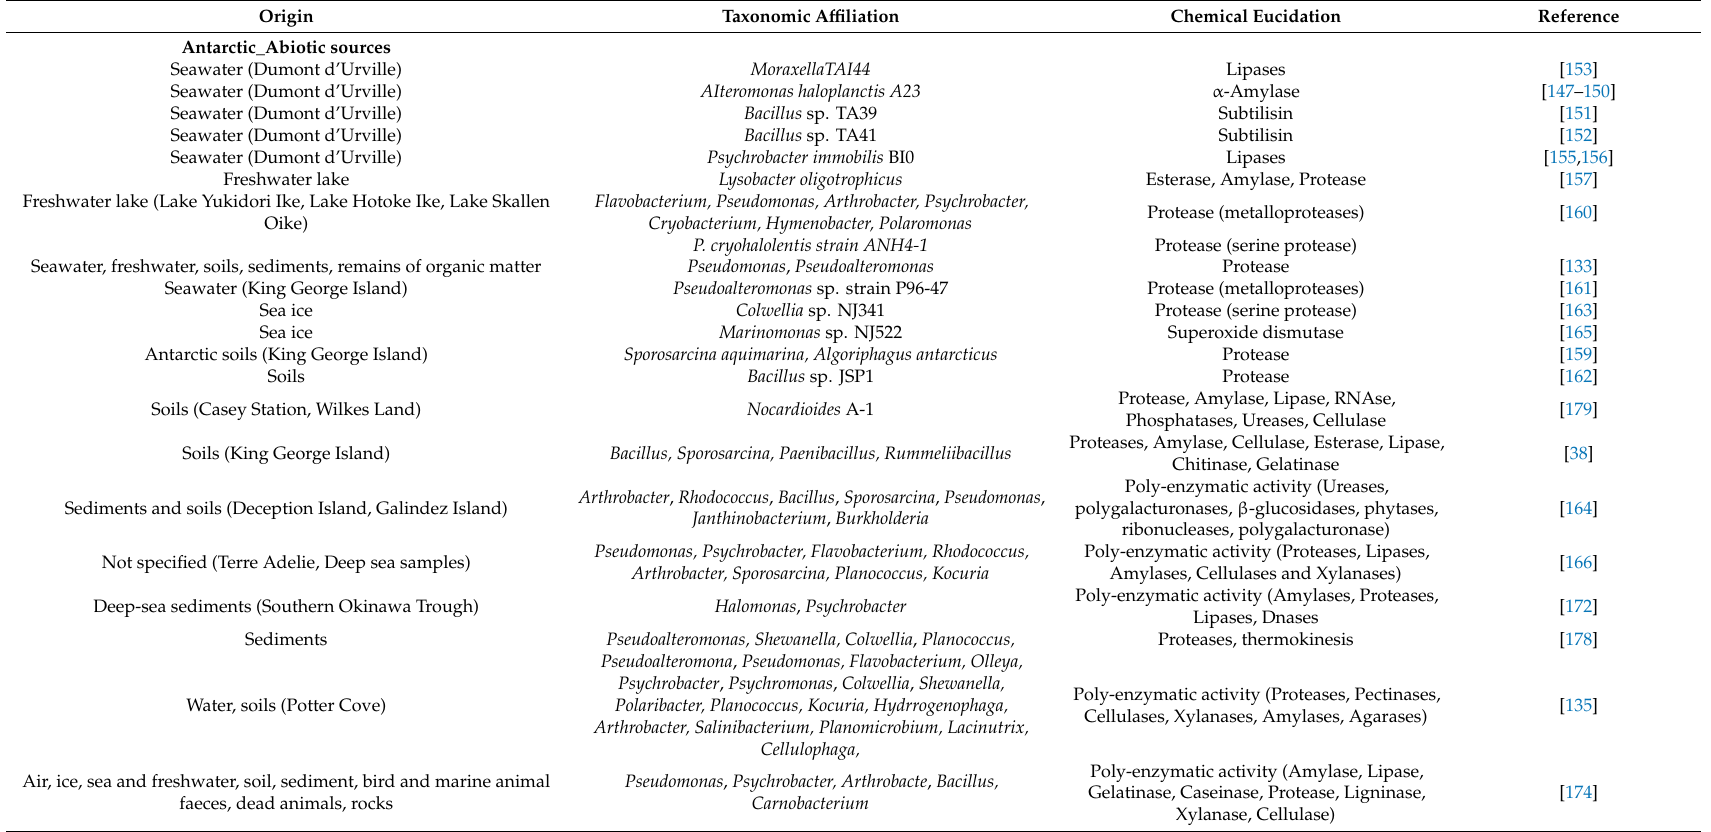
Table 3. List of cold-enzymes bacterial producers considered for the review